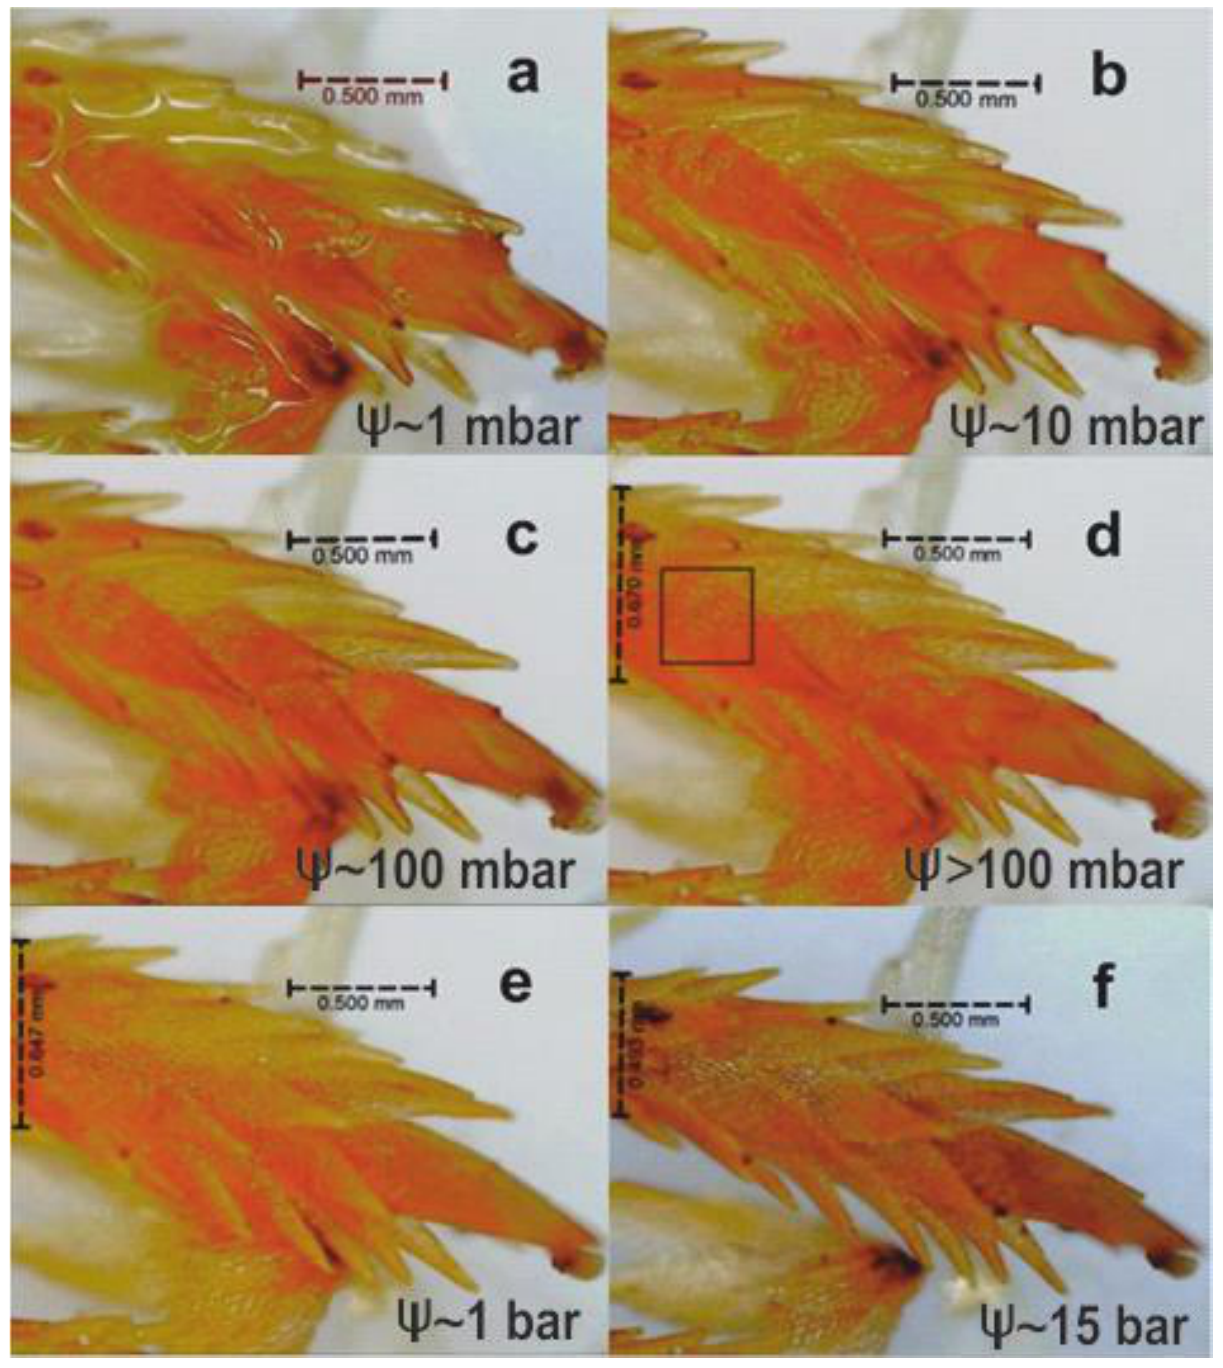
Figure 10. Microscopy observations of a Sphagnum branch subjected to increasing matric water suctions ψ , i.e . undergoing desiccation from a saturated state (a) to the permanent wilting point (f). The unit used here for the matric water suction (mbar) is equivalent to 1 cm (height of the water column). The black square in (d) indicates part of a branch leaf where hyaline cells have been emptied of water and become transparent.